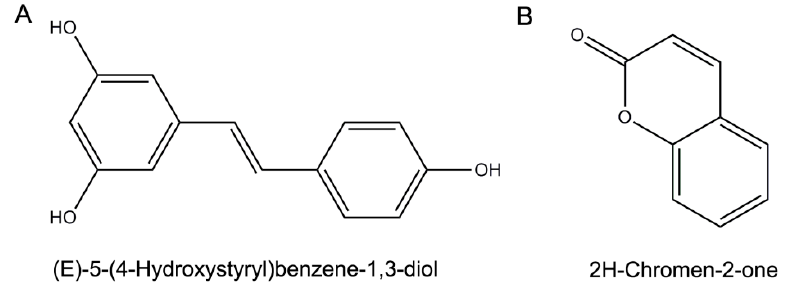
Figure 1. Molecular structural formula and chemical names of: resveratrol ( A ); and coumarin ( B ). Table 2. Effects of different compounds on the growth of R. solanacearum after 24 h incubation. Concentration ( μ g/mL) Compounds